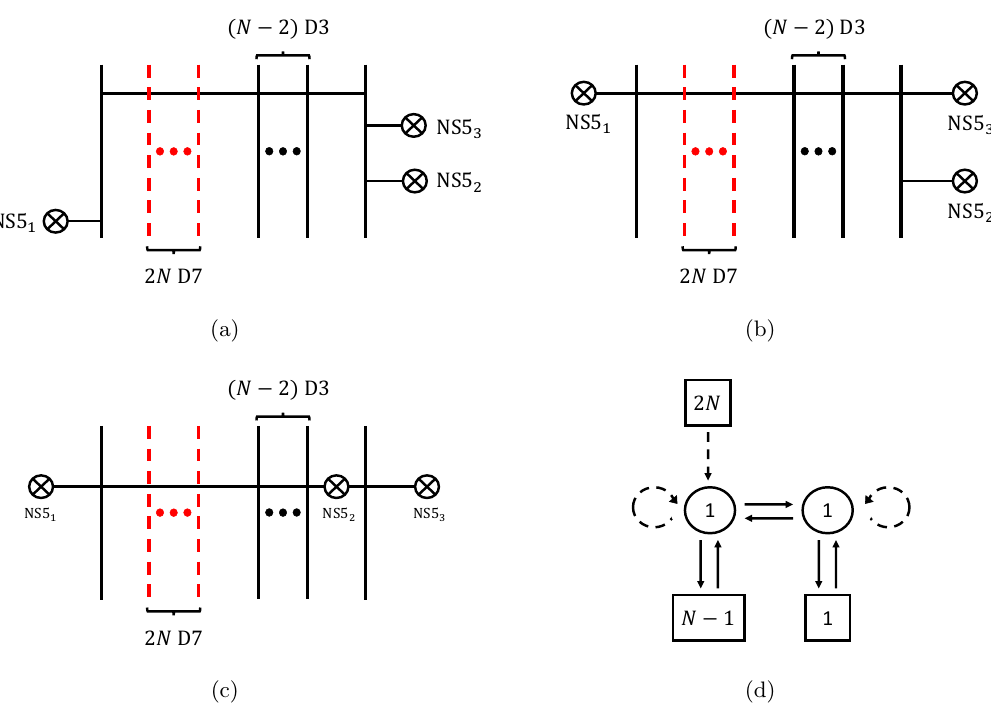
Figure 16 . (a) An introduction of a smooth monopole with magnetic charge e 1 (cid:0) e N to (cid:12)gure 14. (b) We adjust the position of the D1-brane to realize the screening sector v = e N . (c) The brane con(cid:12)guration from which we can read o(cid:11) the SQM for the sector. (d) The corresponding quiver